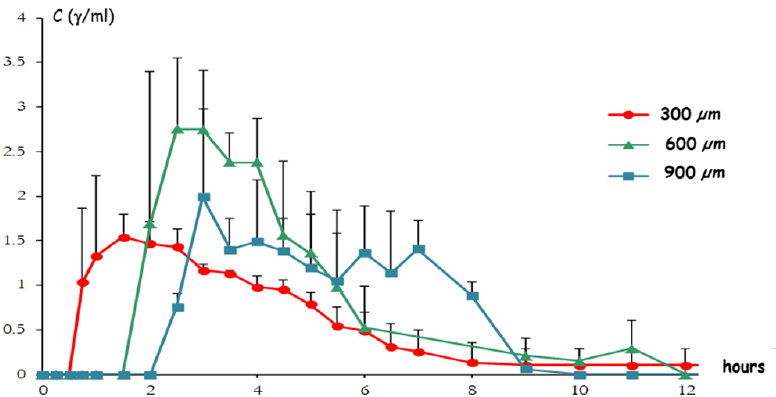
Figure 26. Photographs of the mold set for fabrication of Chronocap ™ capsule shells by injection- molding ( A ) and capsules bodies based on HPC (Klucel ® LF) having 300, 600 and 900 µm thickness ( B ). Adapted with permission from Ref. [67].